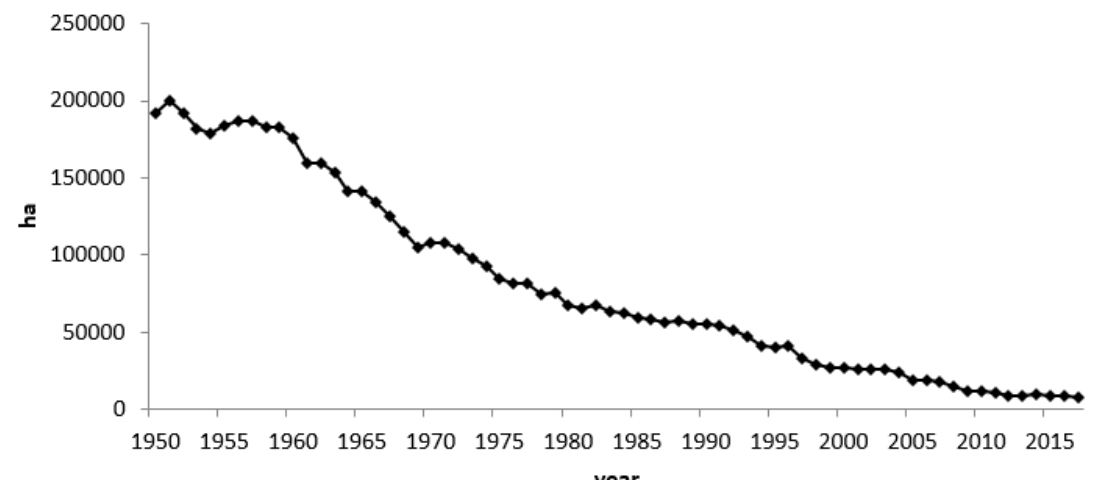
Figure 1. The development of potato cultivation area in Slovakia (1950–2017).